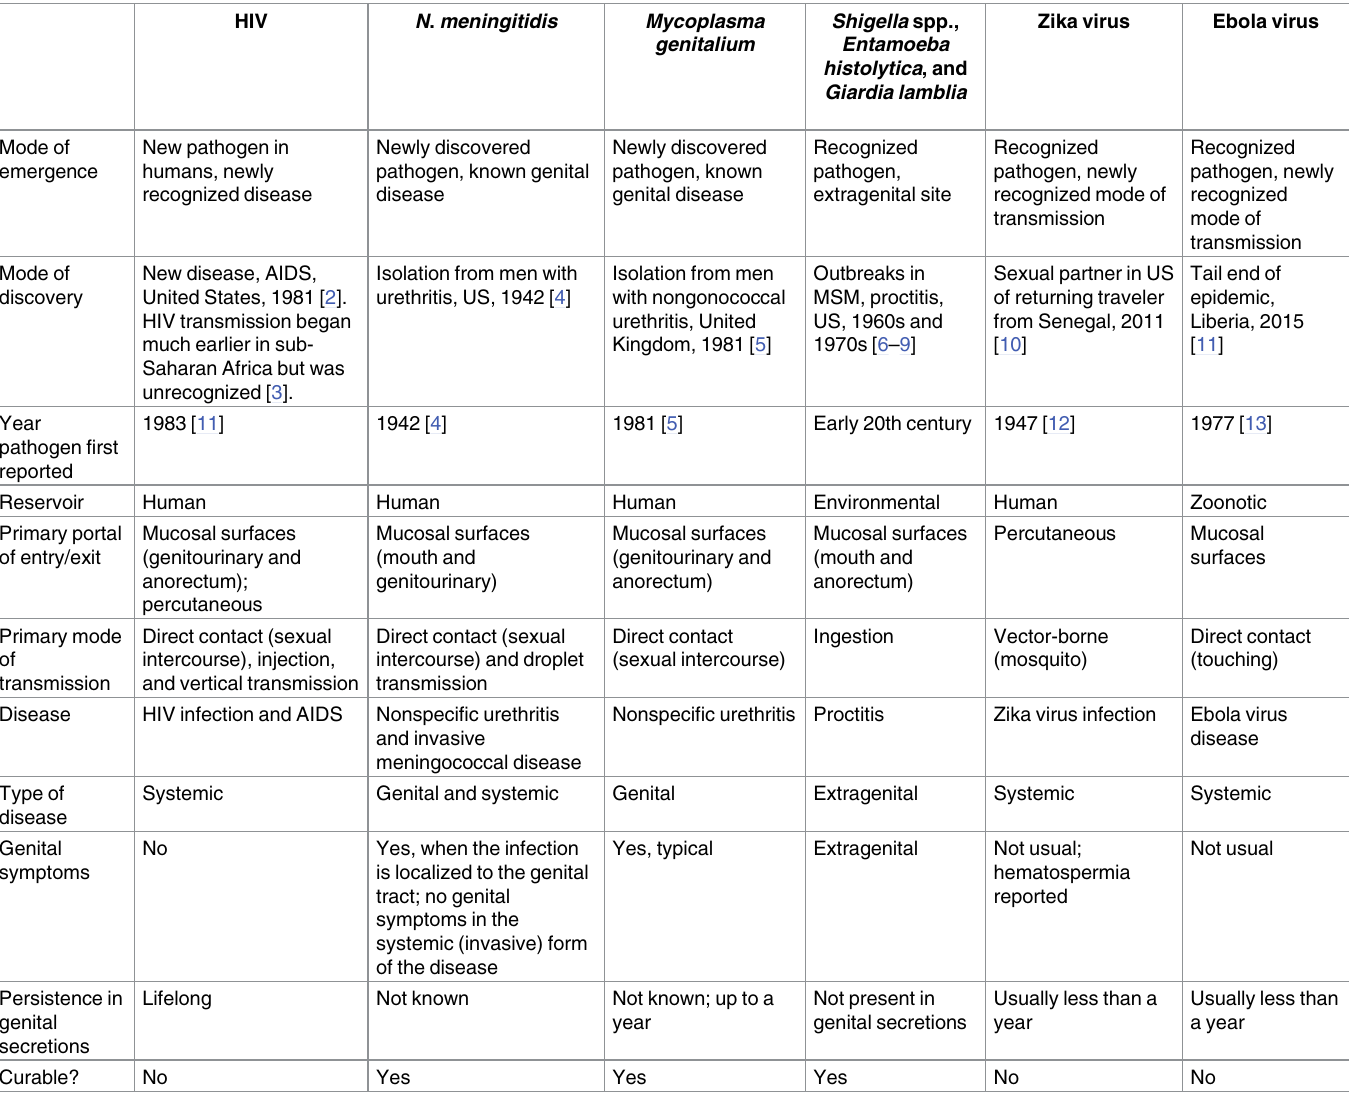
Table 1. Modes of emergenceand key characteristics of selected sexually transmitted infections.